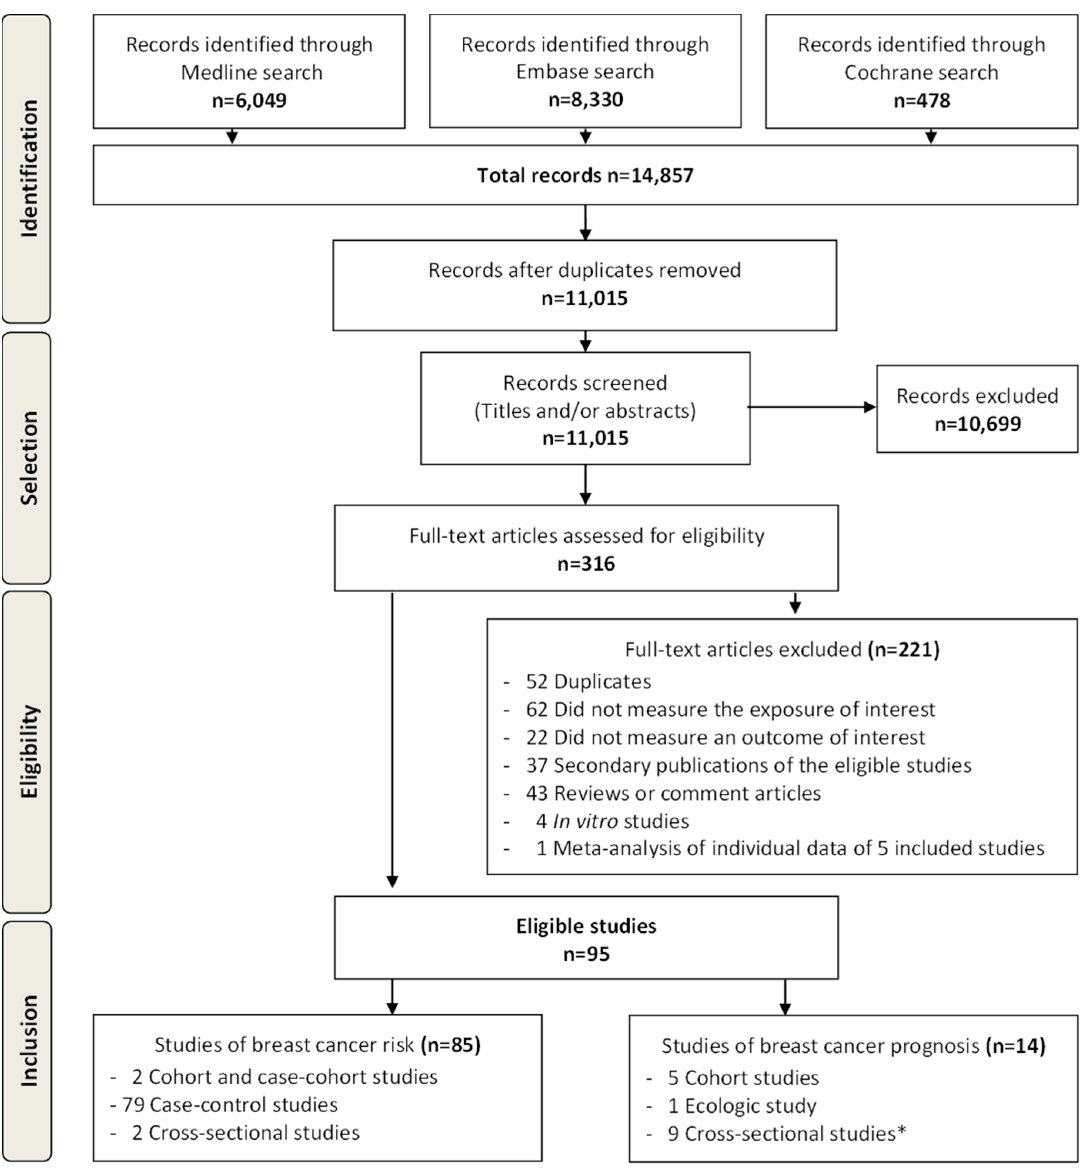
Figure 1. Flow Diagram according to PRISMA (Preferred Reporting Items of Systematic Reviews and Meta-Analyses) [PRISMA], with modifications. *One cohort study on breast cancer mortality also reported cross-sectional analyses of prognostic factors.